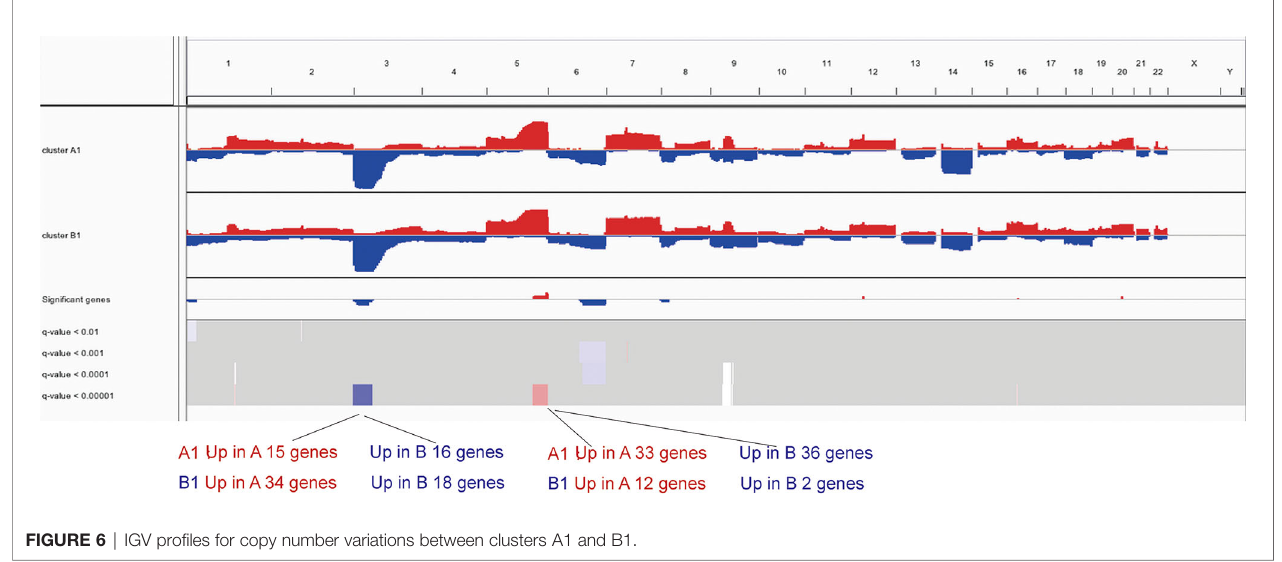
FIGURE 6 | IGV pro fi les for copy number variations between clusters A1 and B1.